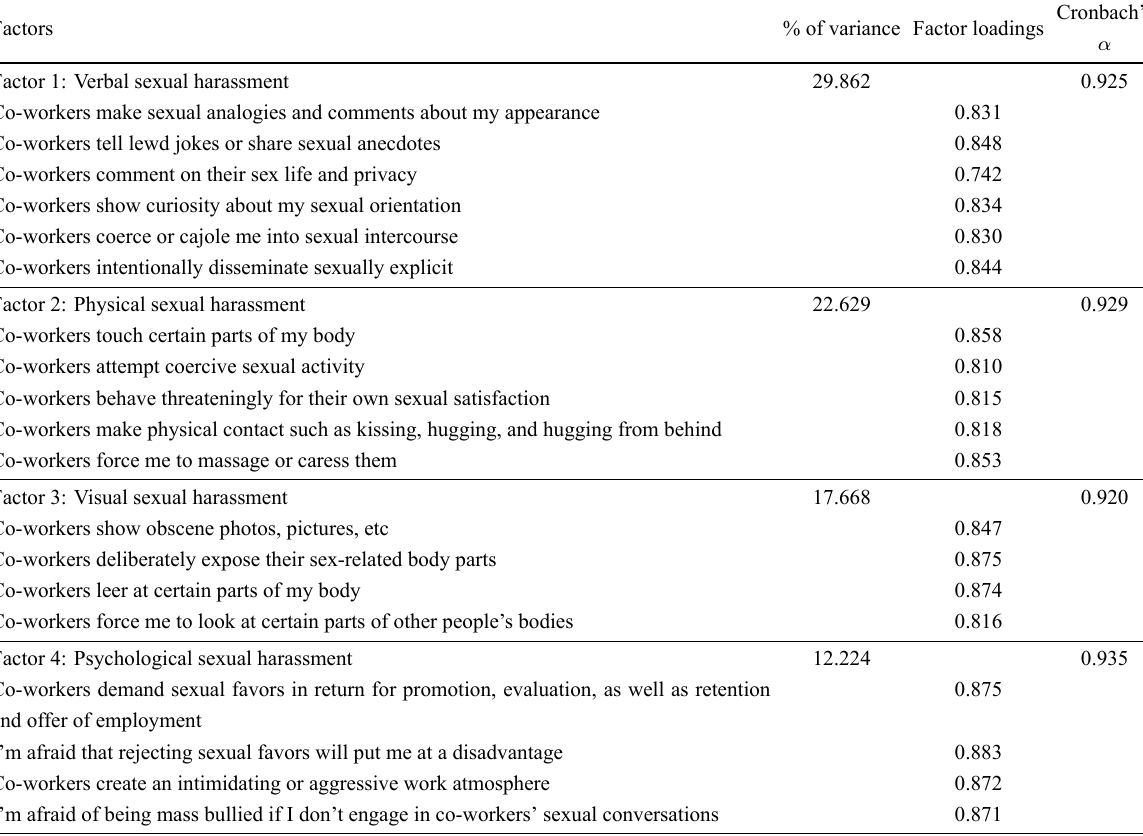
Table 2. Summary of exploratory factor analysis